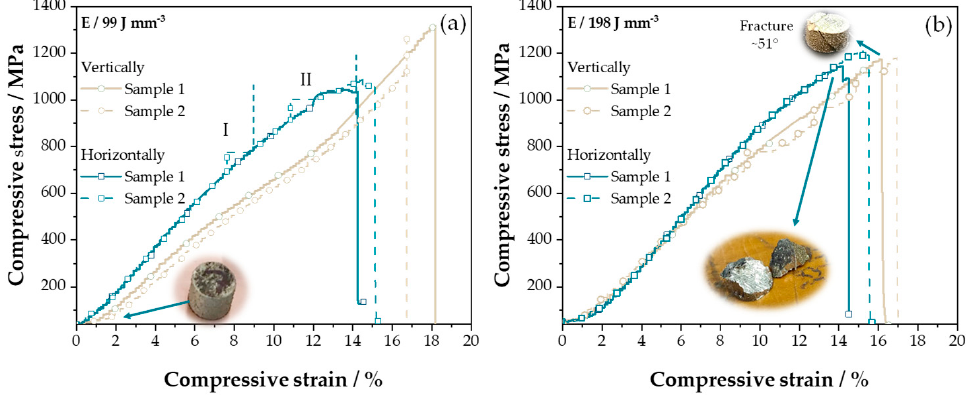
Figure 7. Compression stress-strain curves of samples fabricated in different orientations with E of ( a ) 99 J · mm − 3 and ( b ) 198 J · mm − 3 .